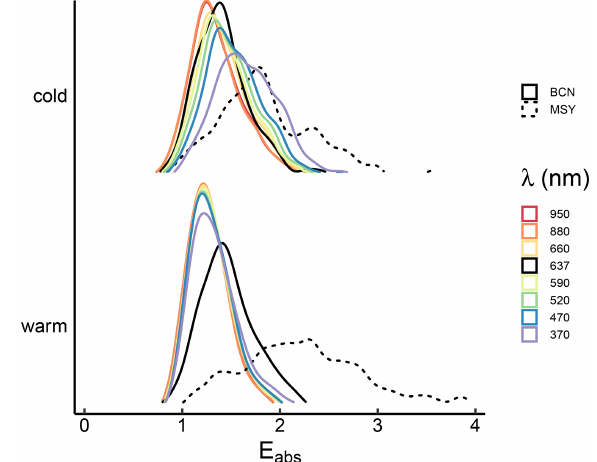
Figure 1. Seasonal frequency distributions of E abs at BCN for the multi-wavelengths measured with AE33 (coloured solid lines for 370, 470, 520, 590, 660, 880 and 950nm), and at BCN (black solid line) and MSY (black dash line) measured with MAAP for 637nm and offline